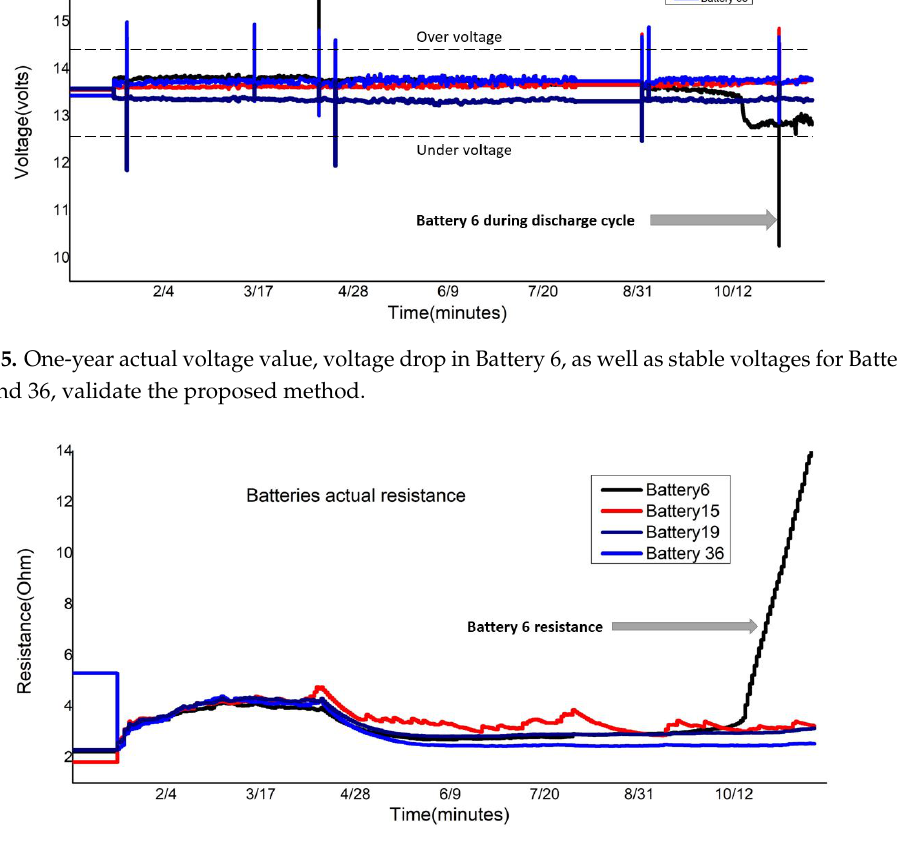
Figure 16. One-year actual resistance value, resistance rise in Battery 6, as well as Stable Resistance for Battery 15, 19, and 36, validate the proposed